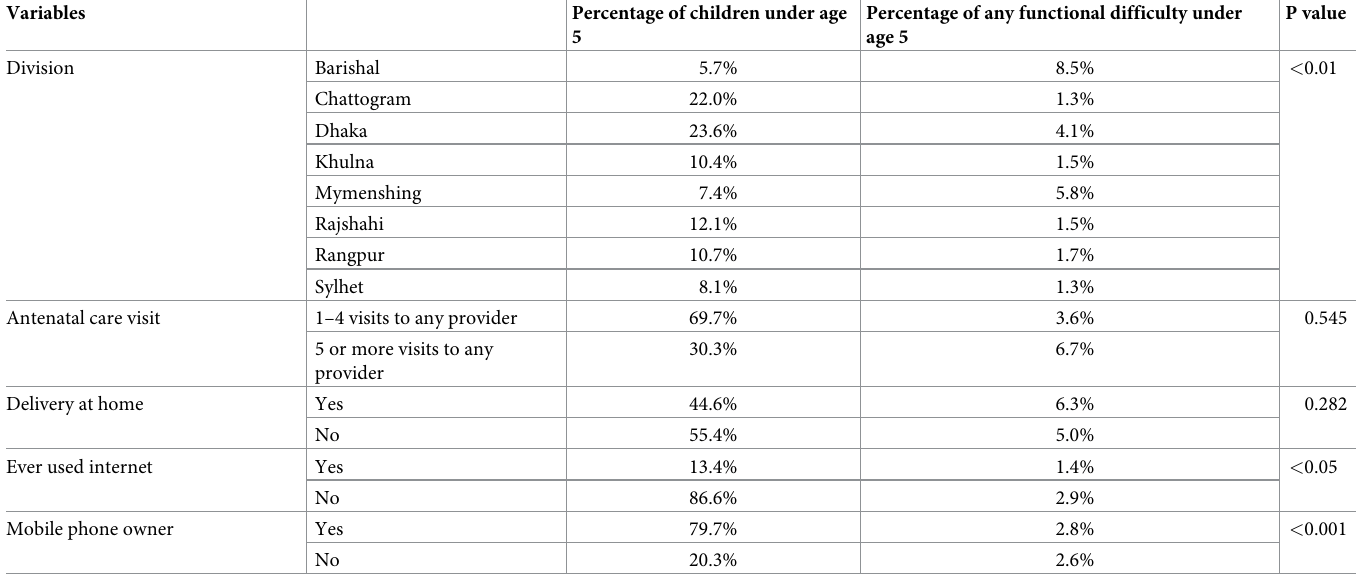
All independent variables with corresponding p values (p values < 0.05) were reported in Table 1. Prevalence of early childhood (aged less than 5 years) disability was found 2.8% at the time of the survey. The prevalence of disability was higher among children aged 2 years (3.0%), male children (3.2%), children who were not attending early childhood education (2.9%). Early childhood disability was significantly higher among underweight (3.4%) and stunt children (3.5%). The prevalence of disability (8.5%) was found to be higher among chil- dren in the 3-plus birth order. Similarly, a significantly higher prevalence of early childhood disability was found among those children whose mothers age was 45 to 49 years age (6.8%) and pre-primary or unedu- cated mother’s children (4.1%). Mothers’ functional difficulty, mothers’ overall happiness was also significantly associated with early childhood disability. Urban children were found to be more disabled than rural (3.3%), but the difference is not significant. Children of those moth- ers who visited antenatal care 5 or more times and had delivered their babies at home, early childhood disability was slightly higher among their children. Similarly, children of those fami- lies who had no access to internet and who owned a mobile phone were significantly associated with early childhood disability. Early childhood disability was also significantly higher among the Barishal division. A divisional variation on prevalence is presented in Fig 6. The ordinal regression model for measuring the risk factors for early childhood disability among the study population was presented in Table 2. The model was fitting well. The statisti- cally significant loglikelihood ratio test ( χ 2 = 49.925; p < 0.001) indicates that the model gives a better prediction for the outcome variables. The Pearson Chi-square test ( χ 2 = 1080.449; p = .129) indicates that the explanatory variables were independent of each other. Additionally, the test of parallel lines indicates that the proportional odds assumption was not violated. The ordinal regression model demonstrated that five significant variables were associated with early childhood disability in Bangladesh. Early childhood disability was higher among those children who were not attending early childhood education (OR = 0.65; 95% CI = 0.13– 1.17; p = 0.01) than those who attained early childhood education. If the mothers